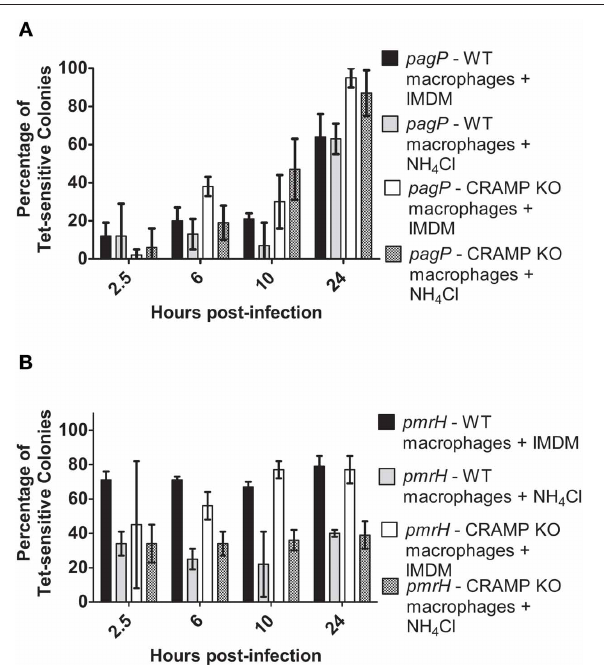
FIGURE 6 | TCRS-mediated pagP and pmrH activation in NH 4 Cl-treated WT and CRAMP KO macrophages. BALB/c and CRAMP-deficient mouse bone marrow-derived macrophages were pre-treated with NH 4 Cl in IMDM and infected with the S. Typhimurium (A) pagP or (B) pmrH RIVET strain. Gentamicin-treated macrophages were lysed at 2.5, 6, 10 and 24h p.i. Lysates containing intracellular bacteria were plated on LB. Resulting colonies were patched onto LB and LB Tet to detect loss of Tet-resistance due to promoter activation. Graphed values represent the mean ± standard deviation of one representative experiment performed three times in triplicate.